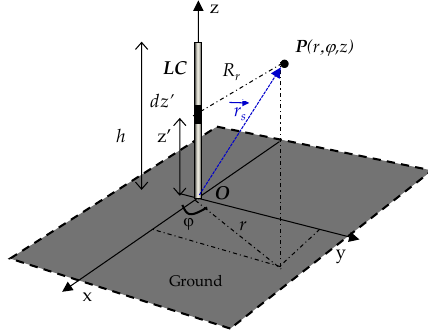
Figure 2. Vertical lightning channel.